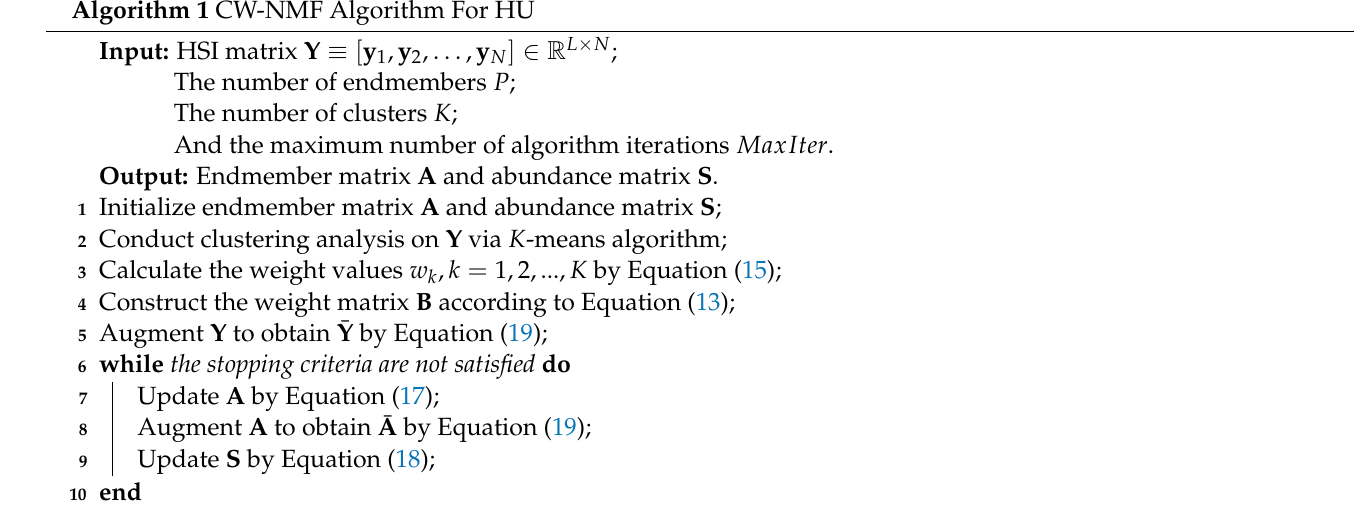
Algorithm 1 CW-NMF Algorithm For